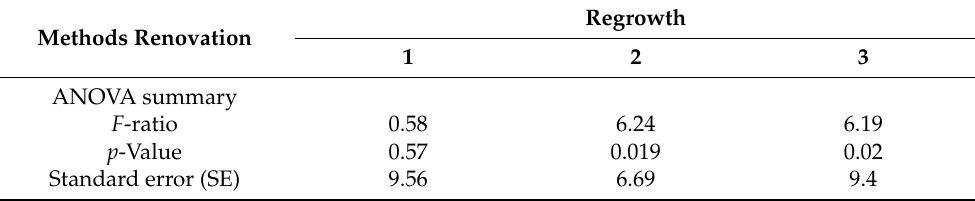
Figure 1. Three-year averages of weed weight by grassland renovation method and by regrowth. P—ploughing; H—harrowing; NR—non-renovated (control treatment). In regrowth, the same letter above a column means no significant difference between the means. Table 3. ANOVA summary of the average dry weed weight for 2014–2016.